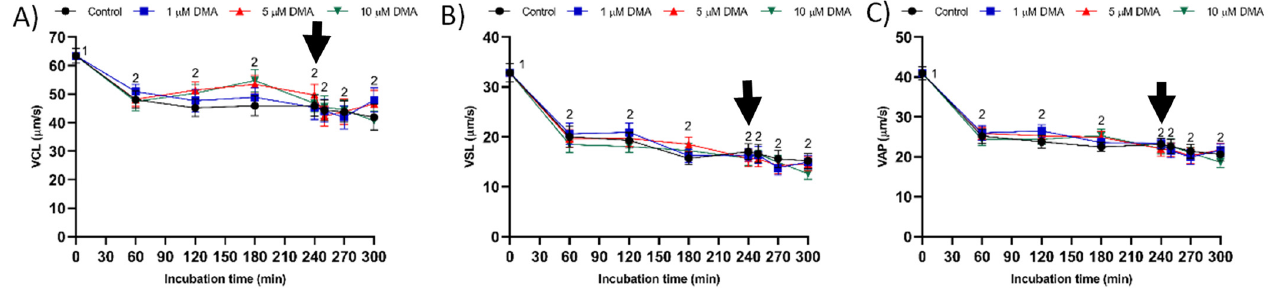
Figure 4. VCL ( A ), VSL ( B ), and VAP ( C ) during in vitro capacitation in the control and samples blocked with 1, 5, and 10 µM of DMA. Different numeral superscripts indicate significant differences between two consecutive time points within a treatment ( p < 0.05); since the pattern of variation of VCL, VSL, and VAP was similar between control and blocked samples throughout the incubation time, all treatments have the same numeral superscript assigned to each time point. The arrow indicates the addition of 10 µg/mL of progesterone at 240 min of incubation. Results are expressed as the mean ± SEM ( n = 9).